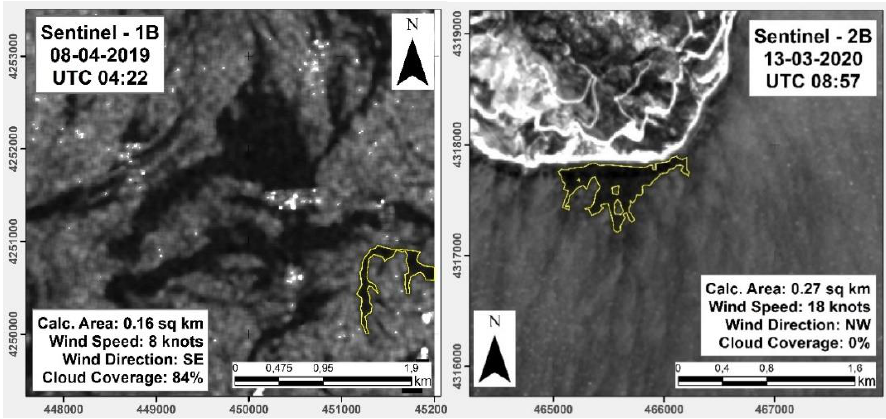
Figure 11. Two examples of false positive classifications with Sentinel-1 (left) and Sentinel-2 (right). Finally, in some cases, the algorithm correctly detected some of the biogenic oil films that existed in the scene. This case was mostly observed in Site 3, where the existence of five independent farms confuses the algorithm. In Figure 12 (captured on 21 May 2020), the film is observed clearly in three farms, while the algorithm correctly detected only one. This could be a result of the thresholds selected.